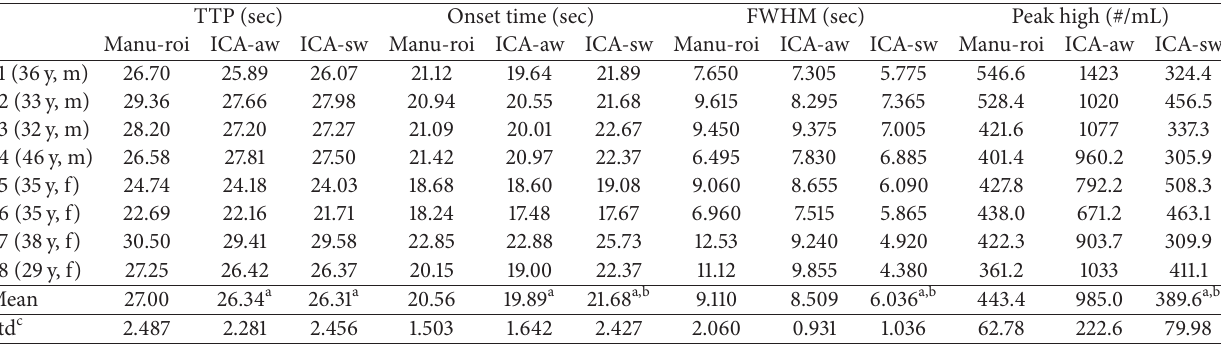
Table 1: Comparisons of time-to-peak (TTP), arrival time (the first time point above the mean time response), FWHM, and peak high after gamma fitting in 8 subjects as determined by manual ROI (Manu-roi) and ICA in artery (ICA-aw) and surrounding tissue (ICA-sw). Below the table, there is statistic comparison with paired 𝑡 -test for manual and weighted-ICA ROI. Significant difference between Manu-roi and ICA-aw ROI is found in TTP, onset time, and peak high and that between Manu-roi and ICA-sw ROI is found in TTP, onset time, FWHM, and peak. For ICA-aw and ICA-sw, there are significant differences in onset time, FWHM, and peak high. TTP (sec)